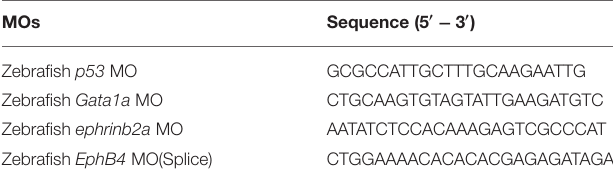
TABLE 1 | Sequencing information of morpholino oligonucleotides